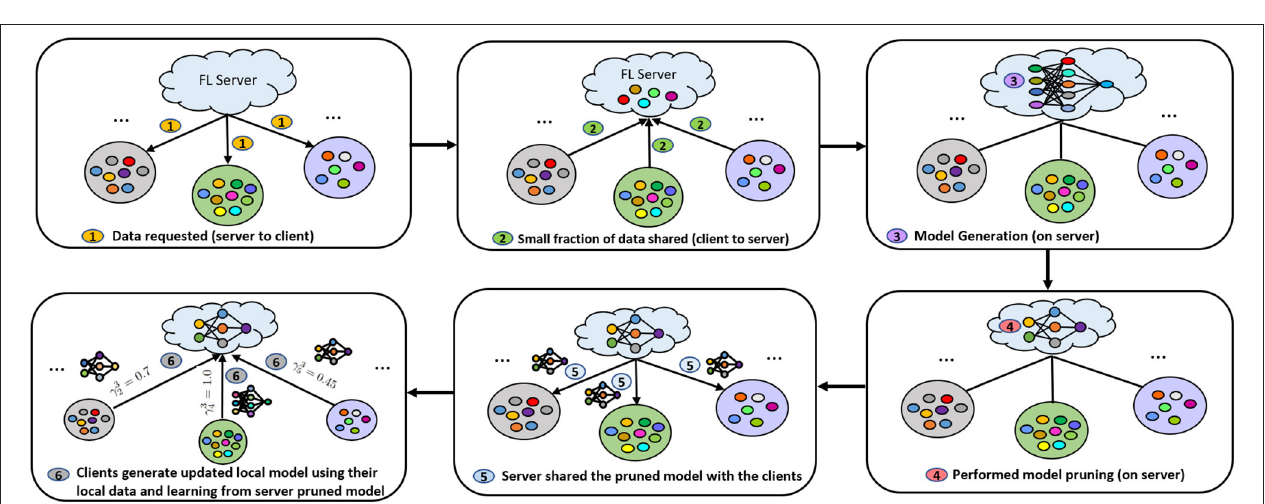
FIGURE 4 | Performing sample-based model pruning on the server and allowing partial amounts of work considering client resource-availability and previous